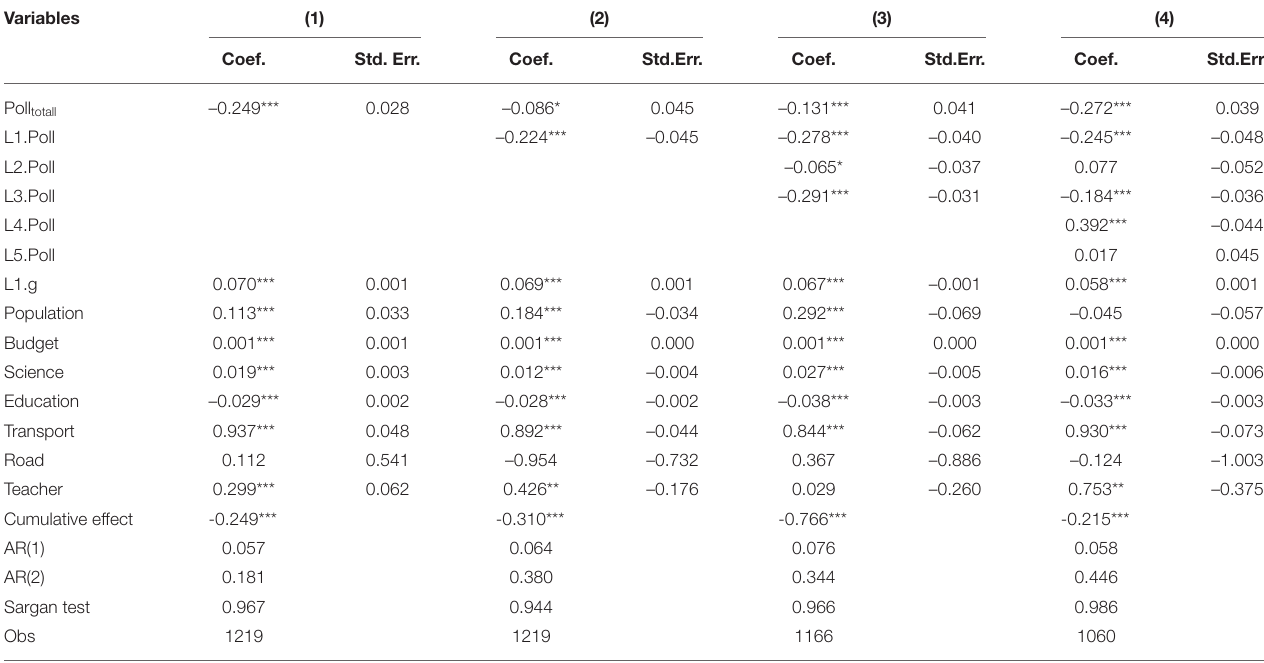
TABLE 5 | Results of dynamic estimates of the impact of total effluent discharge on the volume of output growth.